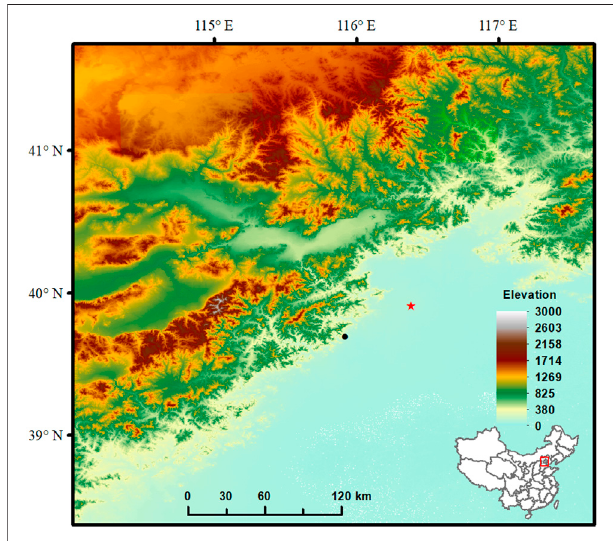
FIGURE 1 | The location of Zhoukoudian